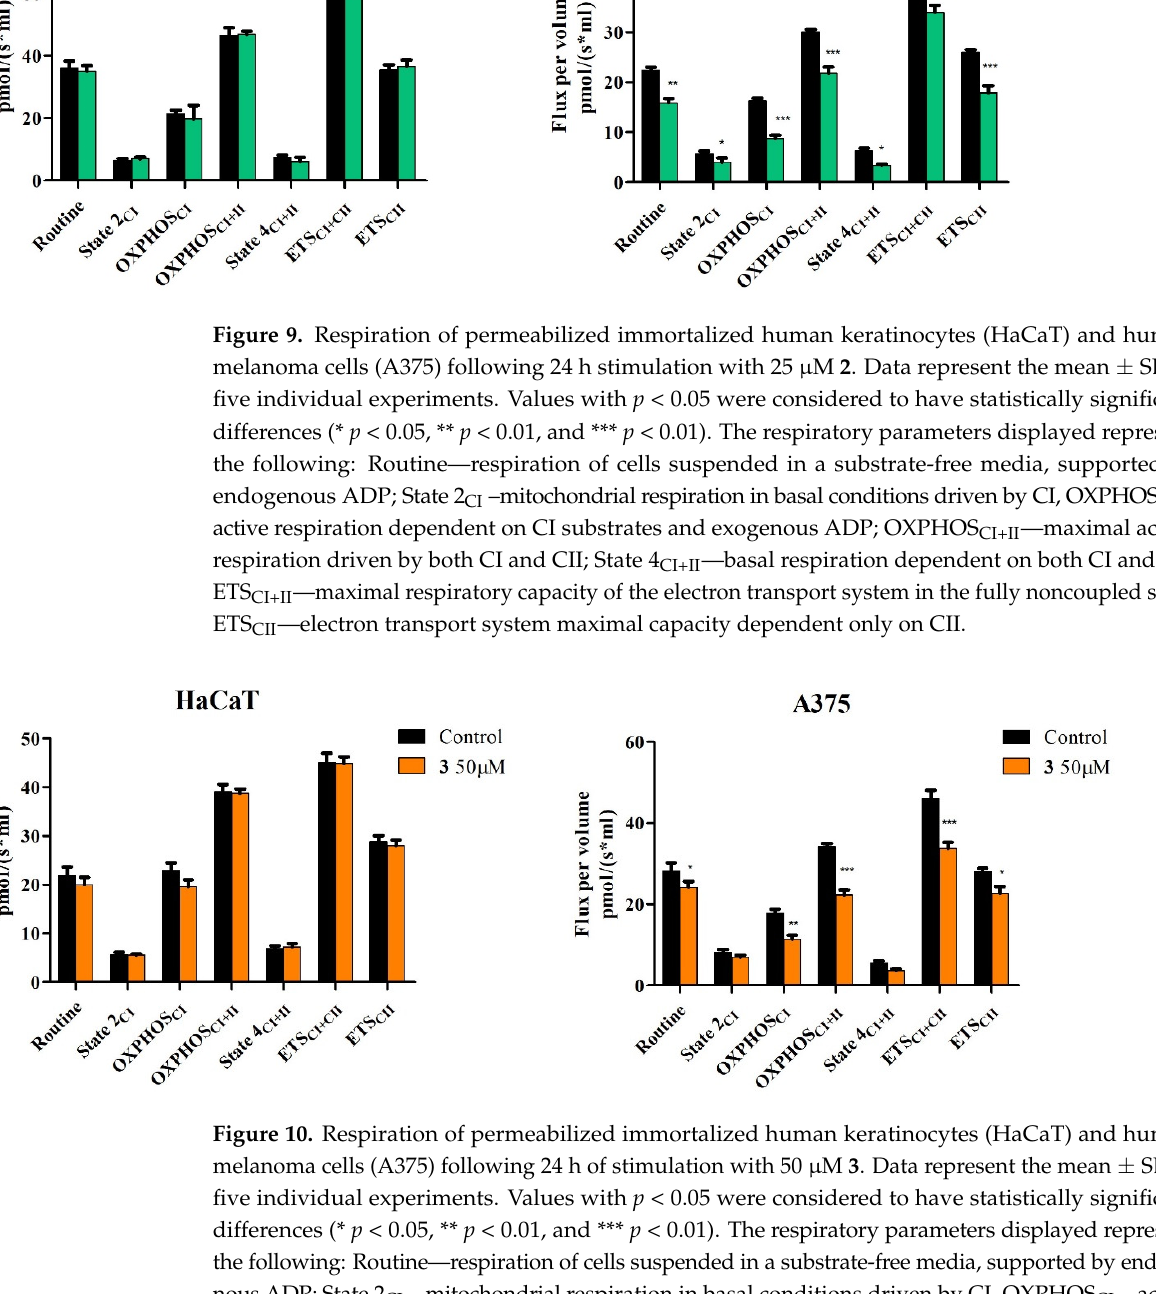
differences (* p < 0.05, and *** p < 0.01). The respiratory parameters displayed represent the